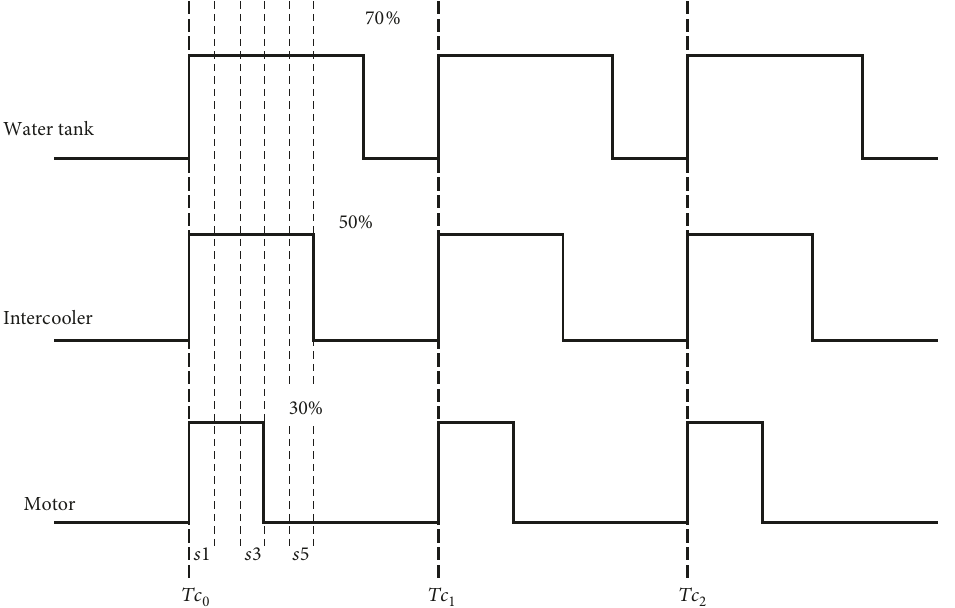
Figure 7: The sketch diagram of the generated PWM